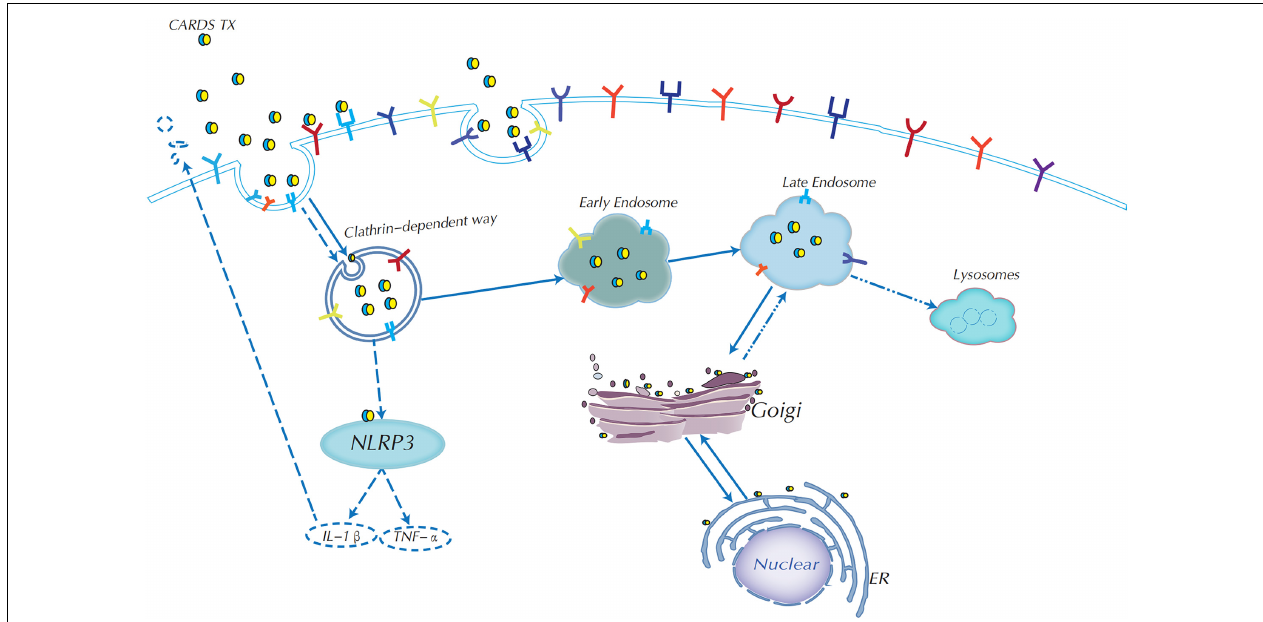
FIGURE 3 | Endocytic mechanism of CARDS TX and signaling pathway diagram. CARDS TX could use receptor-clathrin-mediated endocytosis from early endosomes to late endosomes to enter host target cells. CARDS TX is trafficked by endoplasmic reticulum (ER) to the Golgi complex, most importantly, it could use Golgi complex retrograde transport to the ER in the help of the special KELED sequence, and subsequently transported outside the cell. CARDS TX could activate the NLRP3 inflammasome to release of IL-1 β and associated